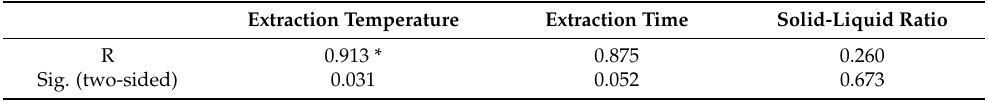
Table 8. Pearson correlation analysis between factors and extraction yield of HCPS. Extraction Temperature